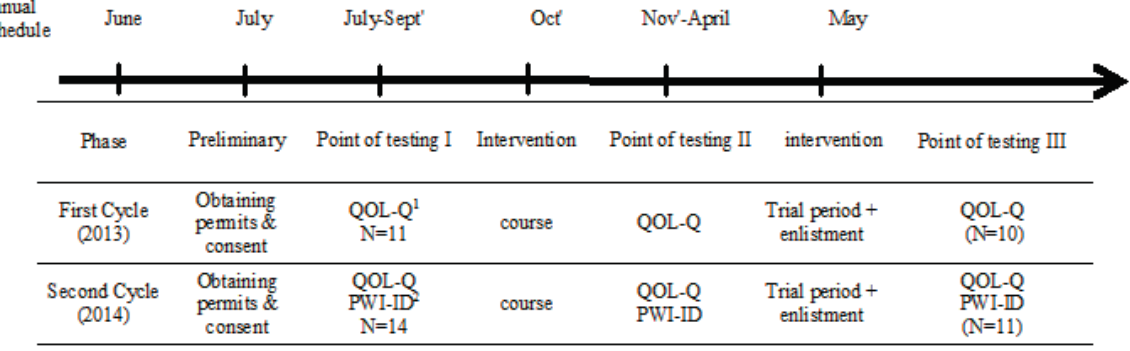
Figure 1. Research time line and procedure. Notes: 1 Quality of Life